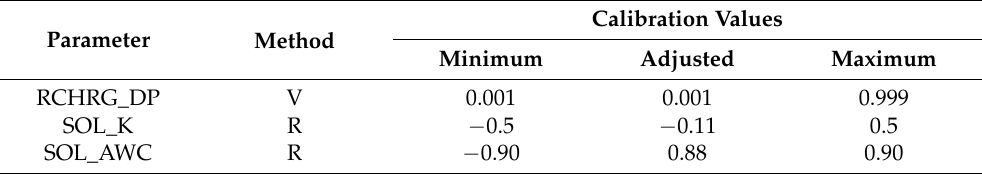
Table 5. Sensitive parameters and their calibrated (adjusted) values.